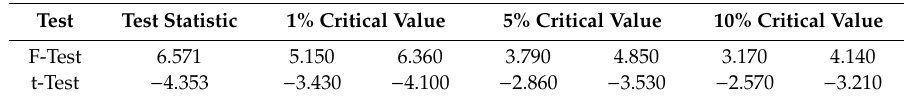
Table A4. Bound test.